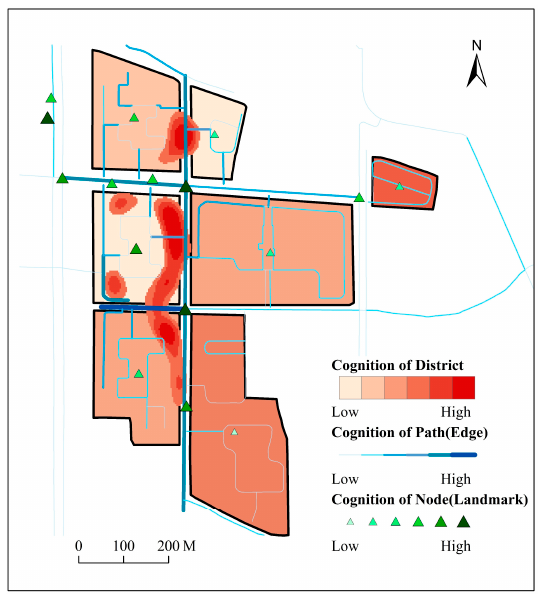
Figure 11. Spatial image map of the Jinghu Community. Second, various image elements in the community space are interconnected. The same data in the community space impact the cognitive results of these three types of elements and are transformed in the process of cognition of various elements. Furthermore, the elements with a higher cognitive level in the Jinghu community spatial image map always appear in combination. Districts with high cognition often include paths with a high frequency of use. Nodes with high cognition mostly appear near paths with high cognition. The highest cognition of the three types of elements in the whole community space is concentrated near the No. 3 Courtyard, which represents a “hot spot” within the